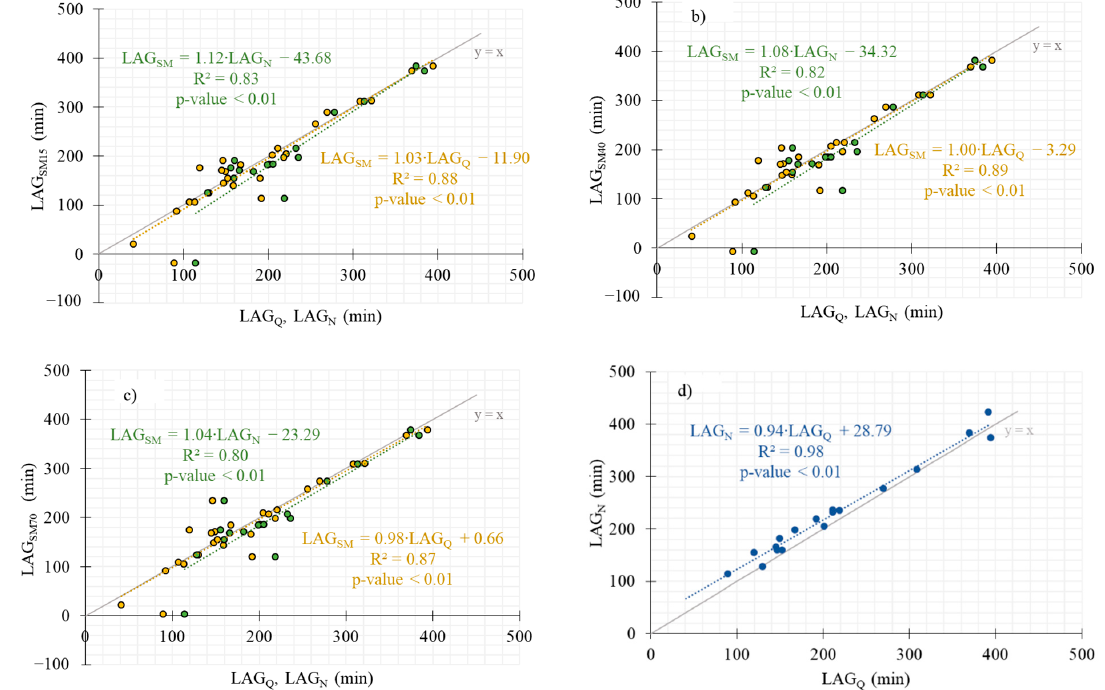
Figure 6. Linear regression between soil moisture centroid lag time (y-axis) and hydrograph and NO 3 -N flux centroid (x-axis) without events, where rainfall duration was longer than 1 day ( a – c ). Yellow dots represent pairs with LAG Q , green dots represent pairs with LAG N . Linear regression between lag times of NO 3 -N flux first statistical moment and discharge first statistical moment is shown on graph ( d ). Results of multiple linear regression analysis showed that in case of LAG N and LAG Q , 92% and